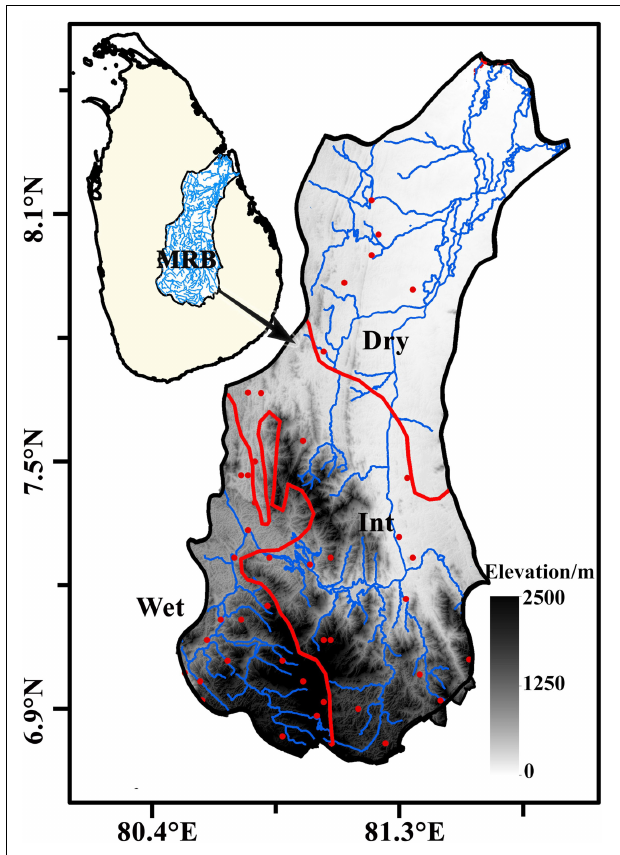
FIGURE 1 | Country location and topographic map of the Mahaweli River Basin (MRB). The spatial distribution of selected rain gauge stations in MRB are shown in red dots. The red lines indicate boundaries for wet, intermediate, and dry sub-regions in the MRB, while the blue line represents the main channel of the Mahaweli